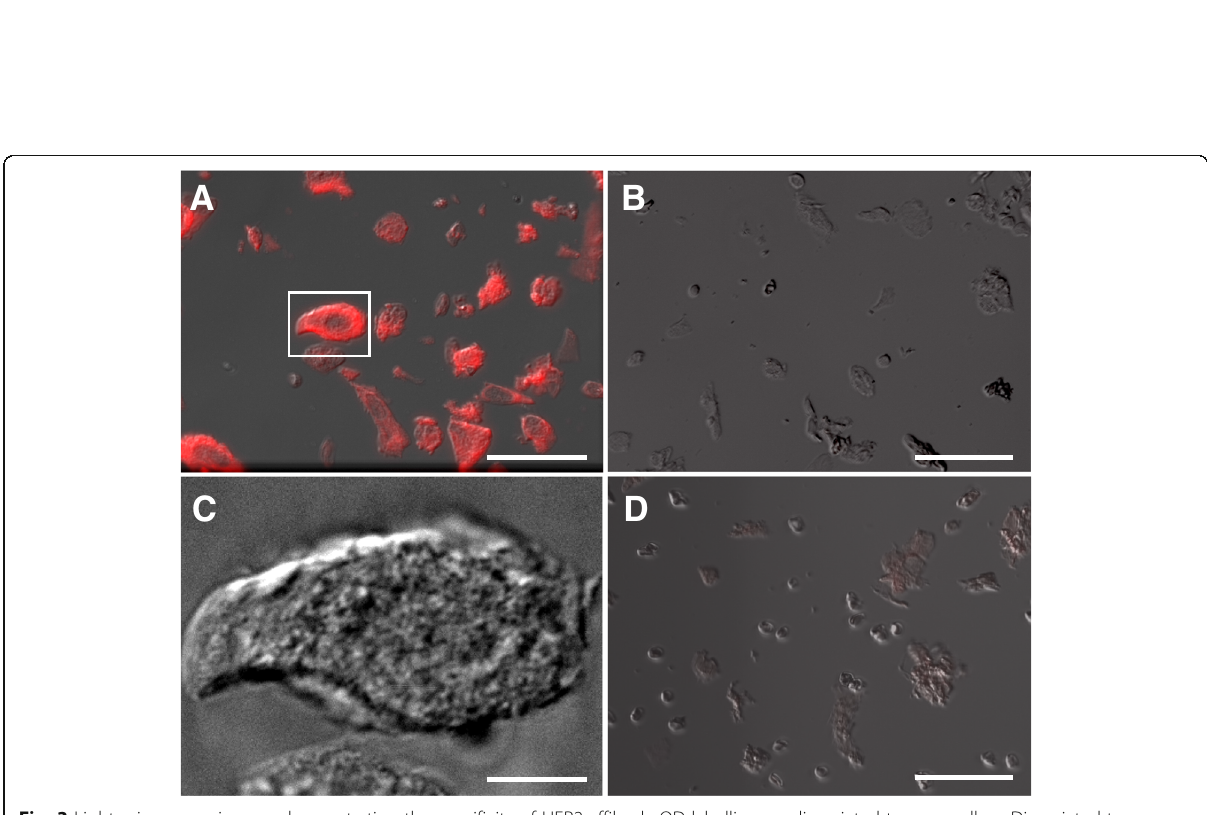
Fig. 3 Light microscopy images demonstrating the specificity of HER2 affibody-QD labelling on dissociated tumour cells. a Dissociated tumour cells with labelled HER2. b Negative control without Affibody incubation for dissociated cells from the same sample as shown in a . c DIC image from the boxed cell in a , acquired with a 63x oil immersion objective. d Dissociated breast cancer cells classified as HER2 negative. The cells were immobilized on a microchip with a silicon nitride window in a and c . In b , and d , the sample was placed in a glass bottom cell culture dish. The images represent an overlay of the fluorescence- and DIC signals except in c . The exposure settings of the fluorescence channel were the same for images a , b , d , and f . Scale bars 50 μ m in a , b , d ; 10 μ m in